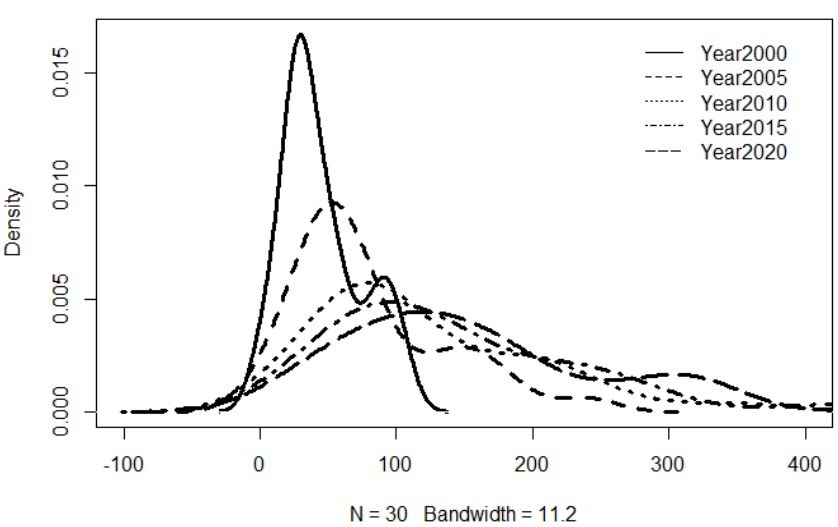
Figure 2. Kernel density estimation of carbon dioxide emissions in China.